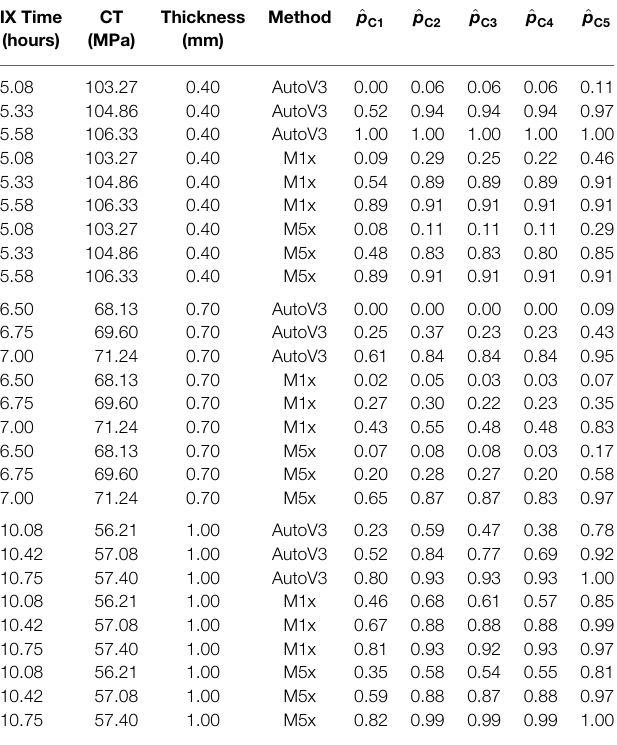
TABLE 7 | Calculated frangibility probability based on various criteria